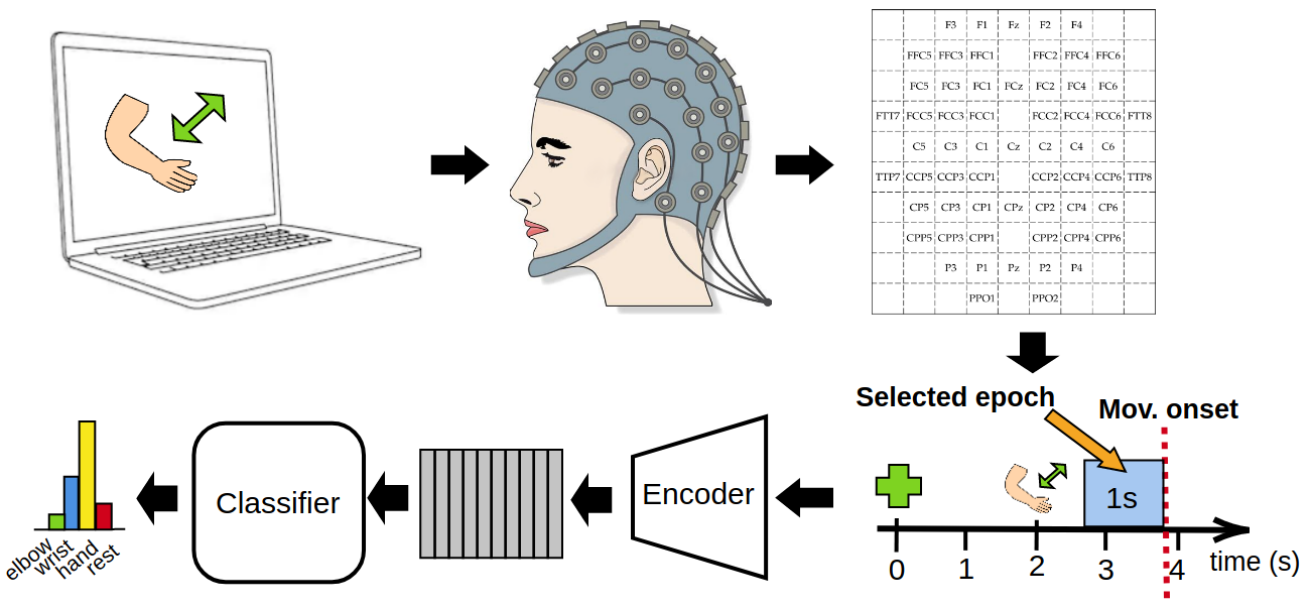
Figure 1. Conceptual schema of the dataset and the acquisition protocol used in this work. The acquired raw electroen- cephalogram (EEG) data is first arranged in our dependendancy-preserving representation. Then, we keep the 1-second segment preceding the movement onset as our training epoch. Each training segment is then encoded and fed to our model to get the final